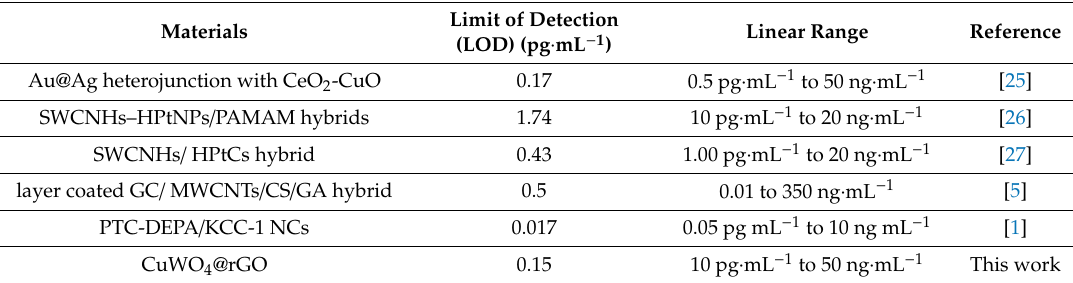
Table 1. Comparison of devised sensors with previously reported electrochemical sensors designed for the quantification of procalcitonin